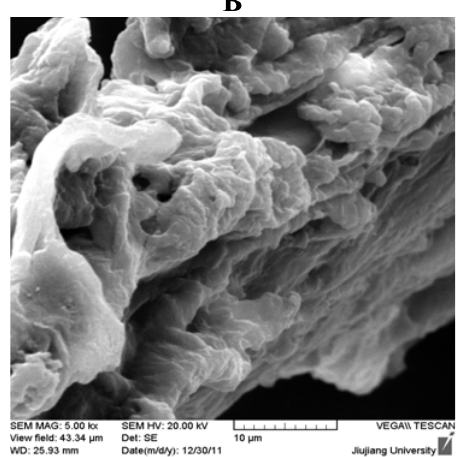
Figure 2. SEM of ( A ) CTS and ( B ) TCCTS